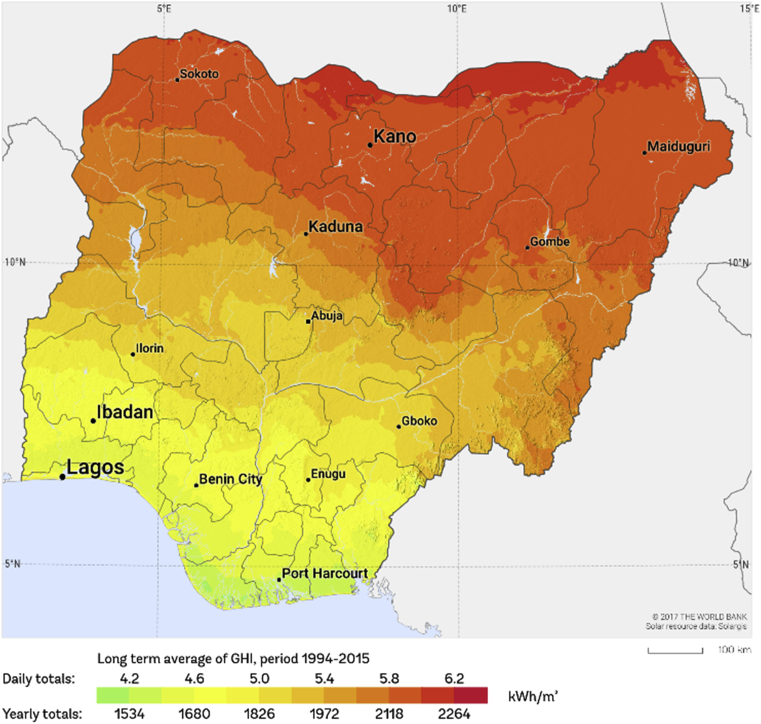
Global Horizontal Irradiation (GHI) map for Nigeria [49].